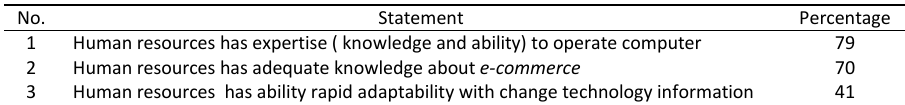
Table 2: Assessment variable competence technology